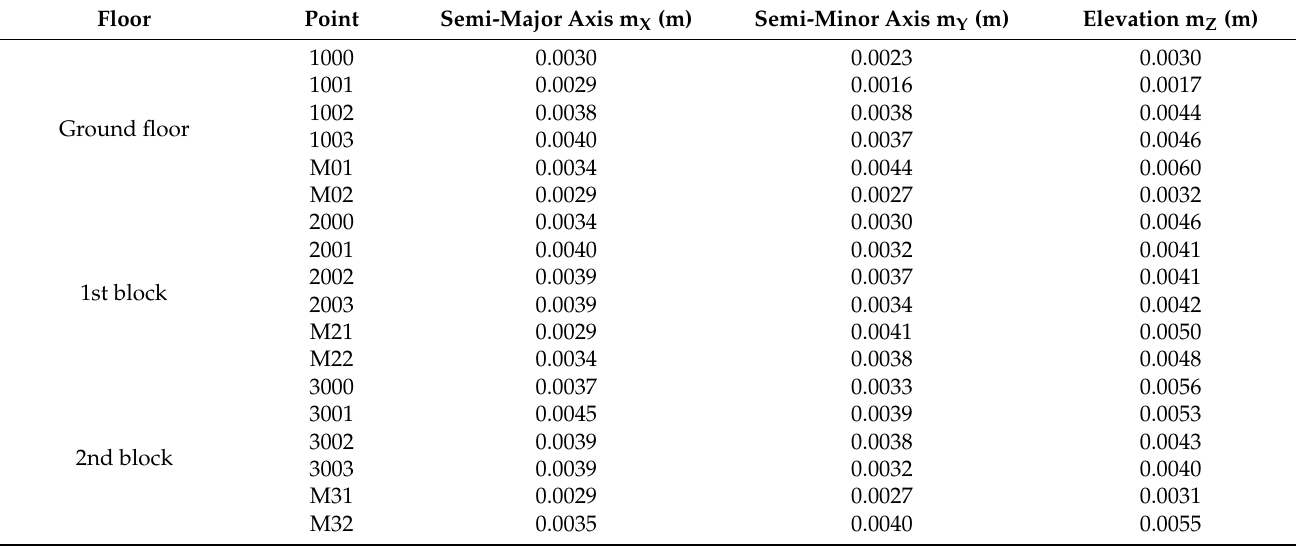
Table A3. The accuracy of the point coordinate